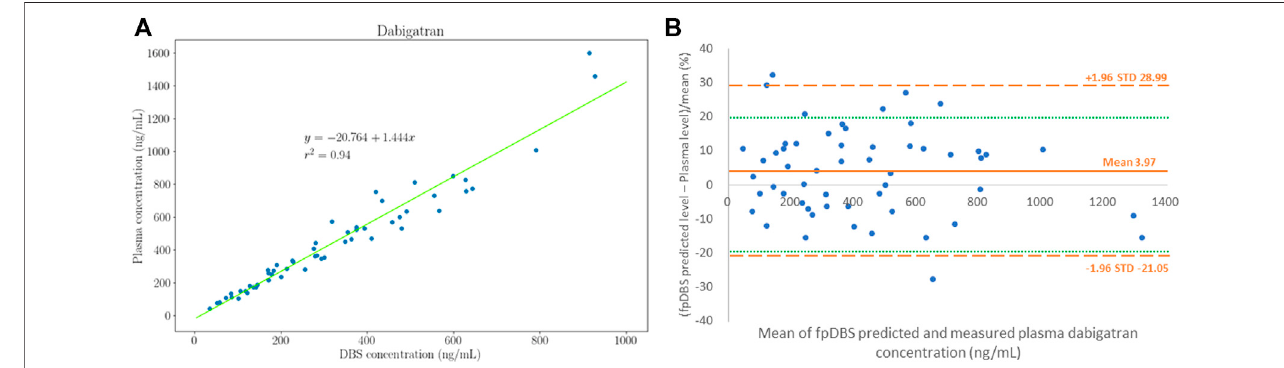
FIGURE 2 | Distribution of plasma and fi nger prick dried blood sampling (fpDBS) dabigatran concentration. (A) The correlation of paired fpDBS and plasma dabigatran concentration, and (B) Bland – Altman plot for dabigatran concentrations that depict the % differences between estimated and measured plasma dabigatran concentrations.